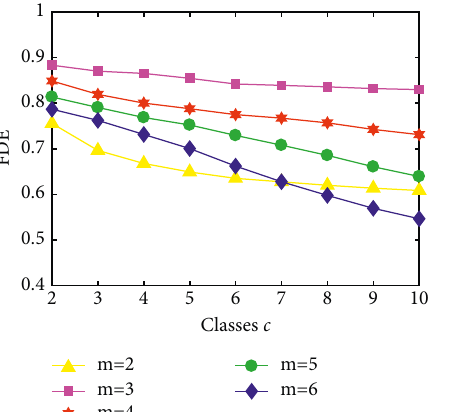
Figure 1: The FDE values of the signal under various embedding dimensions.